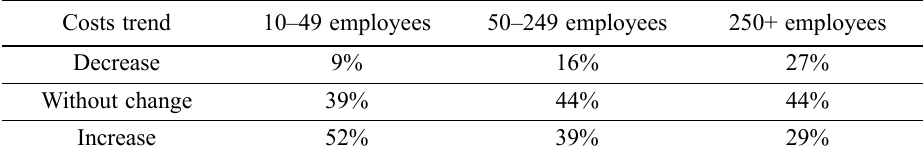
Table 2. Trend in the cost of business informatics by company size Costs